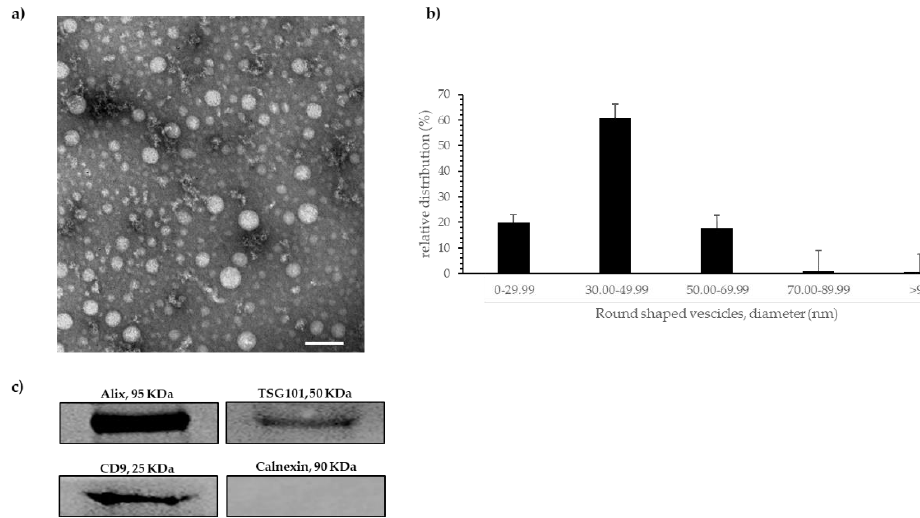
Figure 1. ( a ) Representative Transmission Electron Micrograph of round shaped vesicles. Scale bar = 100 nm. ( b ) Diagram shows the vesicles relative distribution in classes according to their dimensions. c) Western blotting analysis of proteins obtained from the isolated exosomes. Bands show the recognition of the specific exosomal markers Alix, TSG101, and CD9, but not of Calnexin.